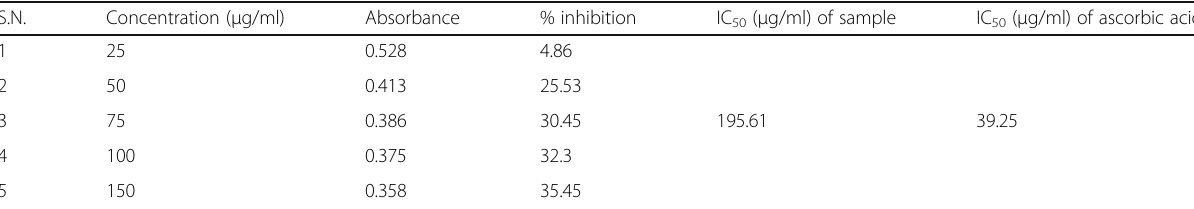
Table 3 Antioxidant activity data of methanol extract S.N.